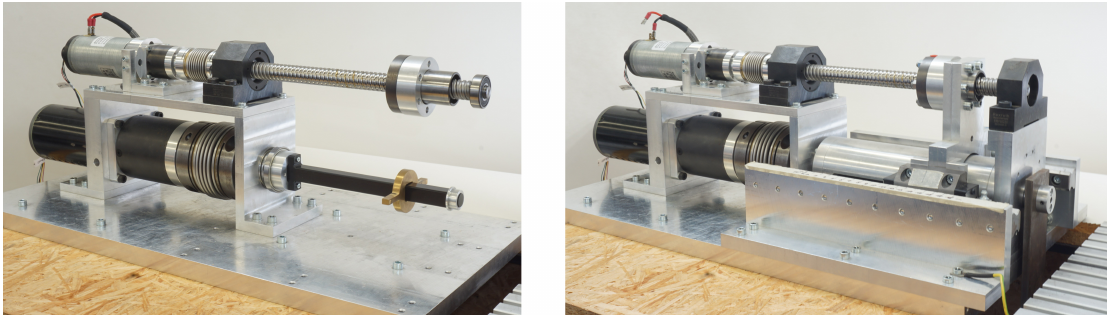
Figure 8. Variable torsion stiffness actuator; partially disassembled ( left ) and assembled ( right